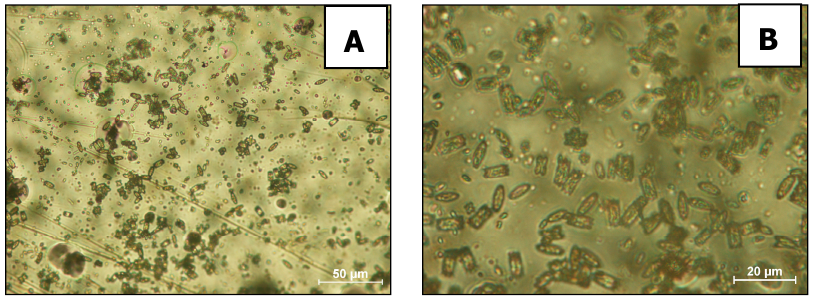
Figure 3. Optical image of CaOx crystals grown in polystyrene films sulphonated and diazotated with aniline. Low at 40× ( A ) and high at 100× ( B ) magnifications.